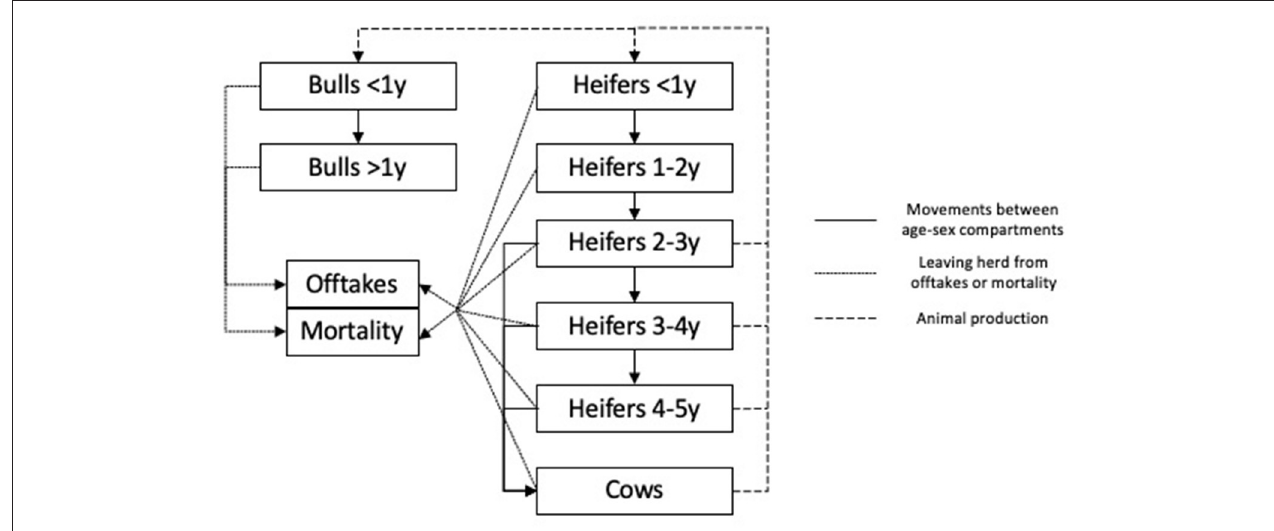
FIGURE 2 | Model framework representing the relationships between annual age–sex compartments for mixed-farming systems considered in the study. Each model was run over a 5-year period.